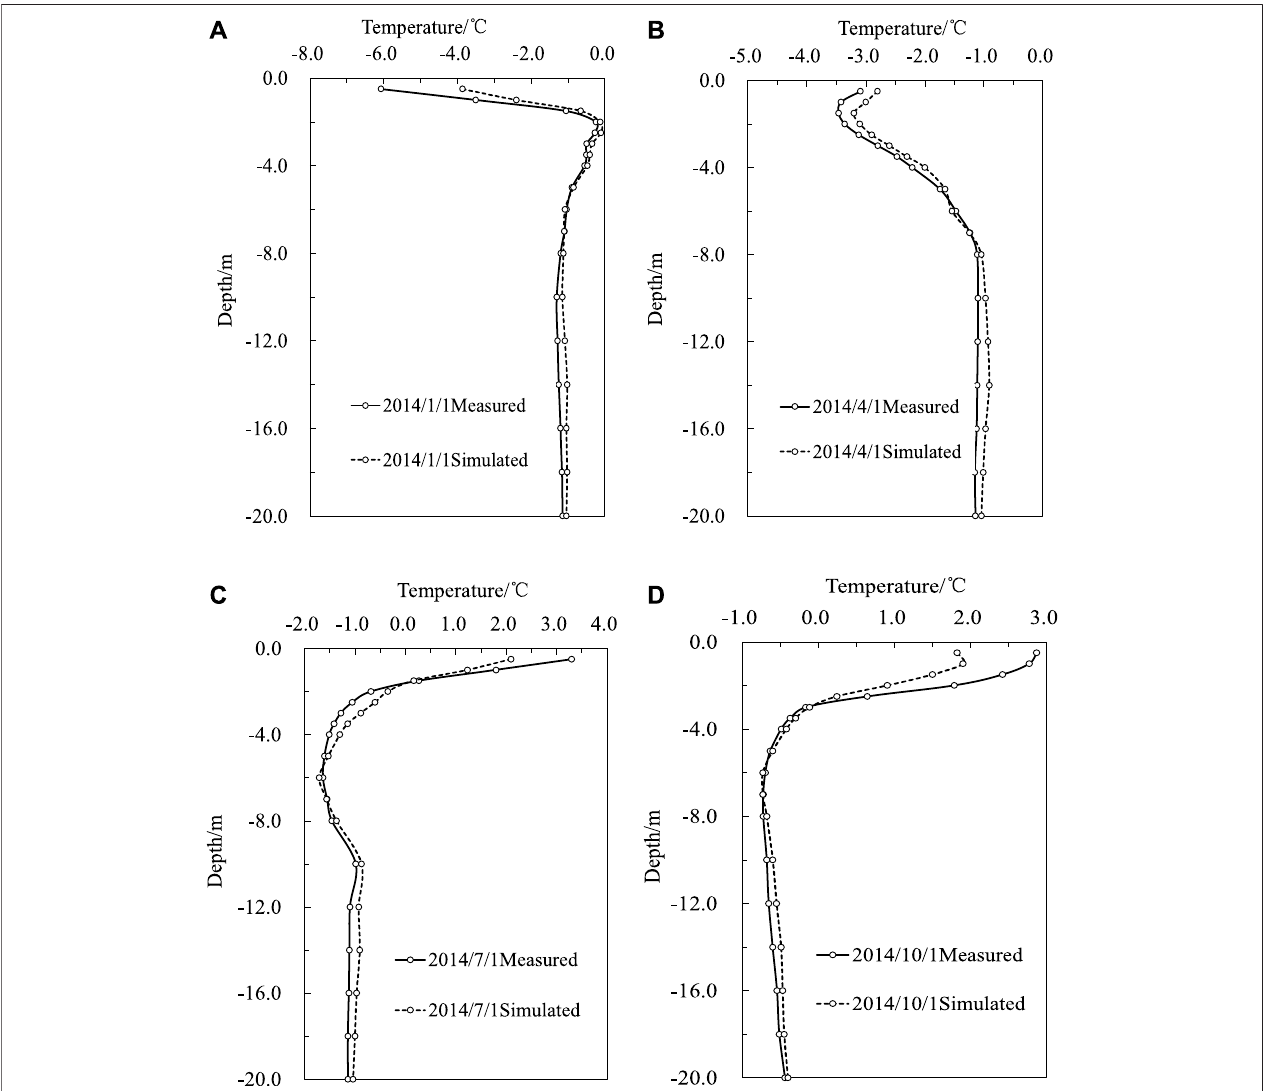
FIGURE 5 | Comparisons of ground temperature between the monitored and the simulated. (A) January. (B) April. (C) July. (D) October.